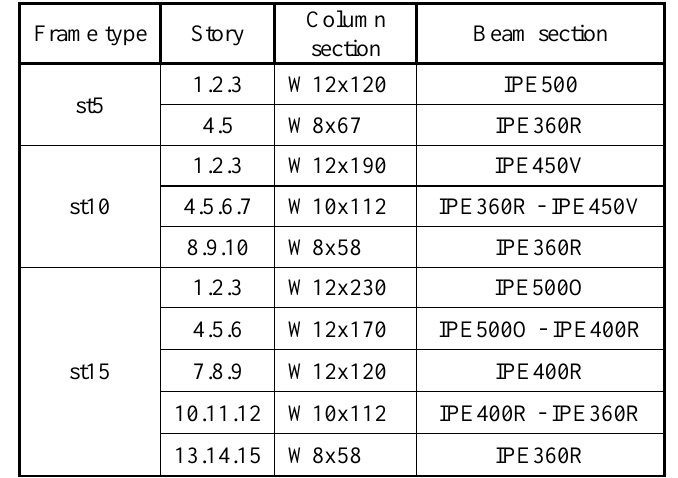
Table. 1 Beam and column sections of